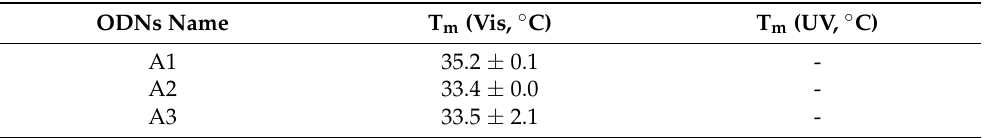
Table 2. The melting temperatures of natural hairpin nucleotides, azobenzene-linked hairpin oligonu- cleotides and azobenzene-linked dumbbell